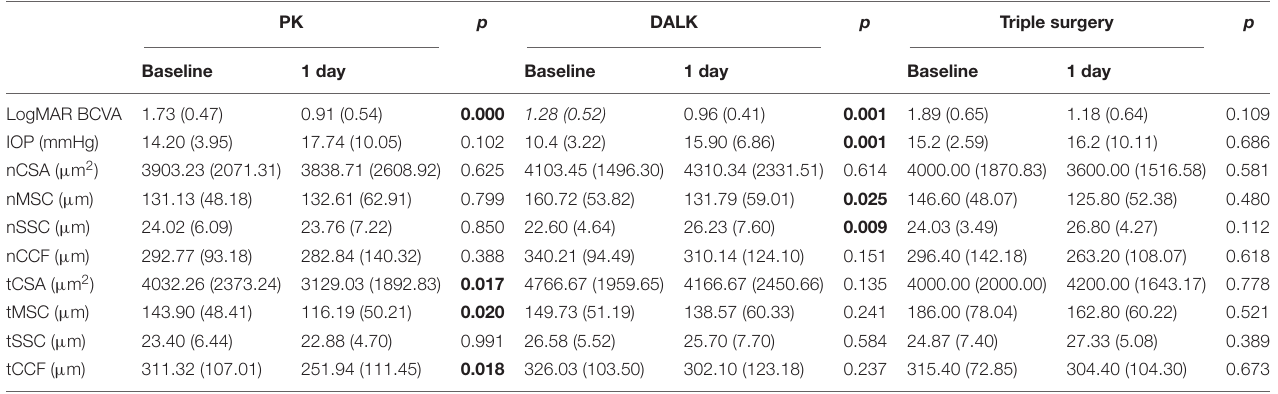
TABLE 3 | Comparisons between preoperative and postoperative (1 day) parameters of different surgeries. PK p DALK p Triple surgery p Baseline 1 day Baseline 1 day Baseline 1 day LogMAR BCVA 1.73 (0.47)